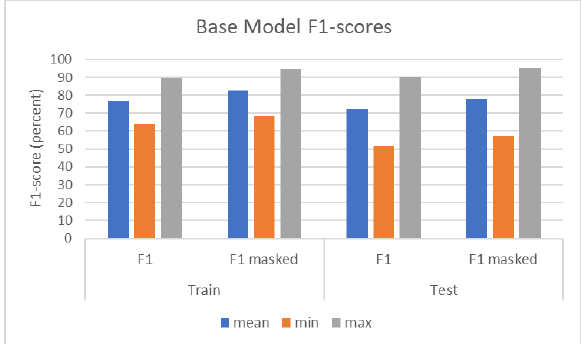
Figure 8. Distribution of 11 training watersheds in the target study area that are used for a best training from scratch model.